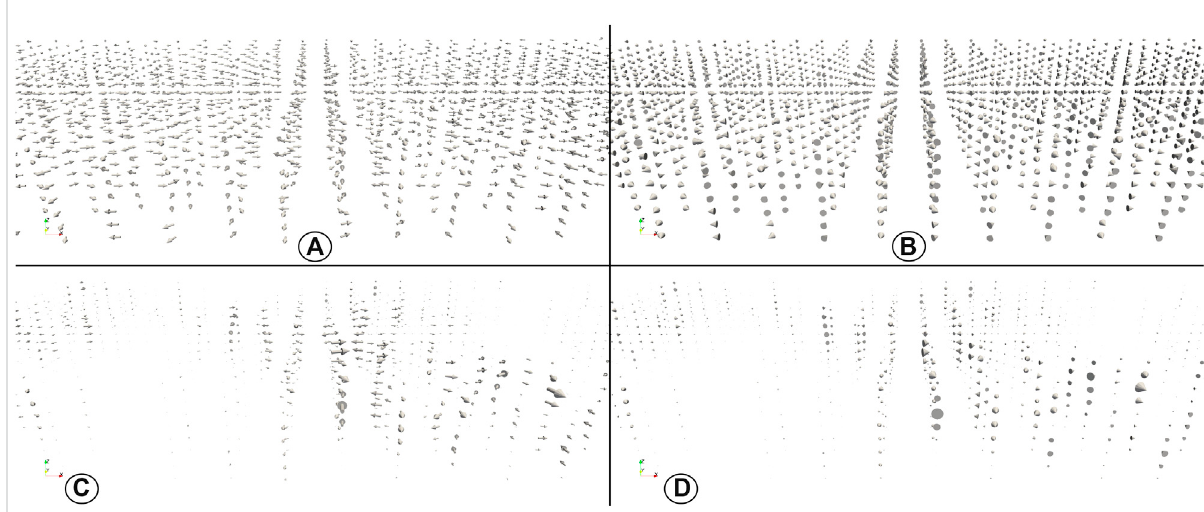
FIGURE 5 Drastic subsampling (A) or glyph replacement with cones (B) does not resolve the outlined clutter hallucinator. Resolving the hallucinator in 3D hedgehog plots is achieved with a | (cid:1) v | -scaled hedgehog plot. In return, it constrains the visualisation either to the impression of the larger principal fl ow direction using arrows (C) , or the identi fi cation of smaller coherent fl ow structures (D)